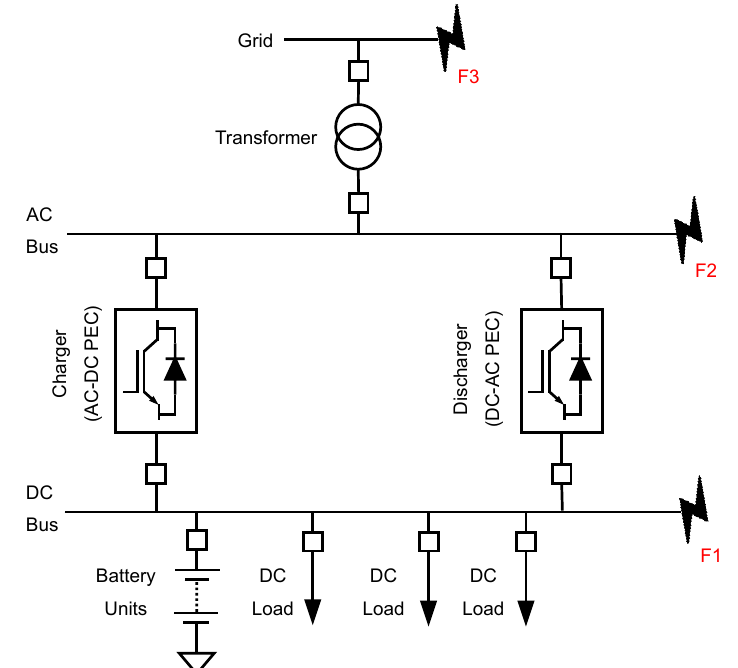
Figure 4. Type of faults in EVs fast-charge